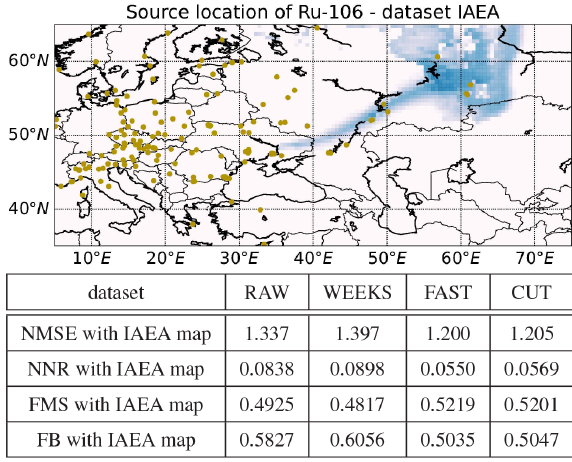
Figure 10. Top: source location of the release of 106 Ru via marginal log likelihood, using the IAEA dataset. Bottom: the computed nor- malized mean square error (NMSE), the normalized mean square error of the distribution of the normalized ratios (NNR), the fig- ure of merit in space (FMS), and the fractional bias (FB) between the source location results obtained using the IAEA dataset and the RAW, WEEKS, FAST, and CUT